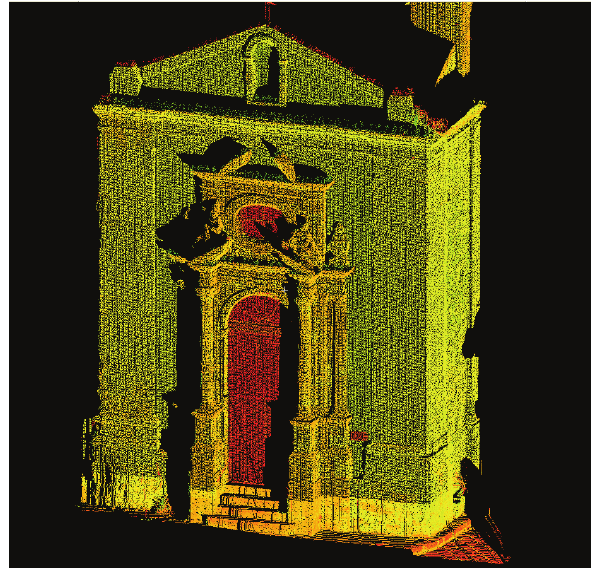
Figure 10. Detailed view of Anime Sante’s church